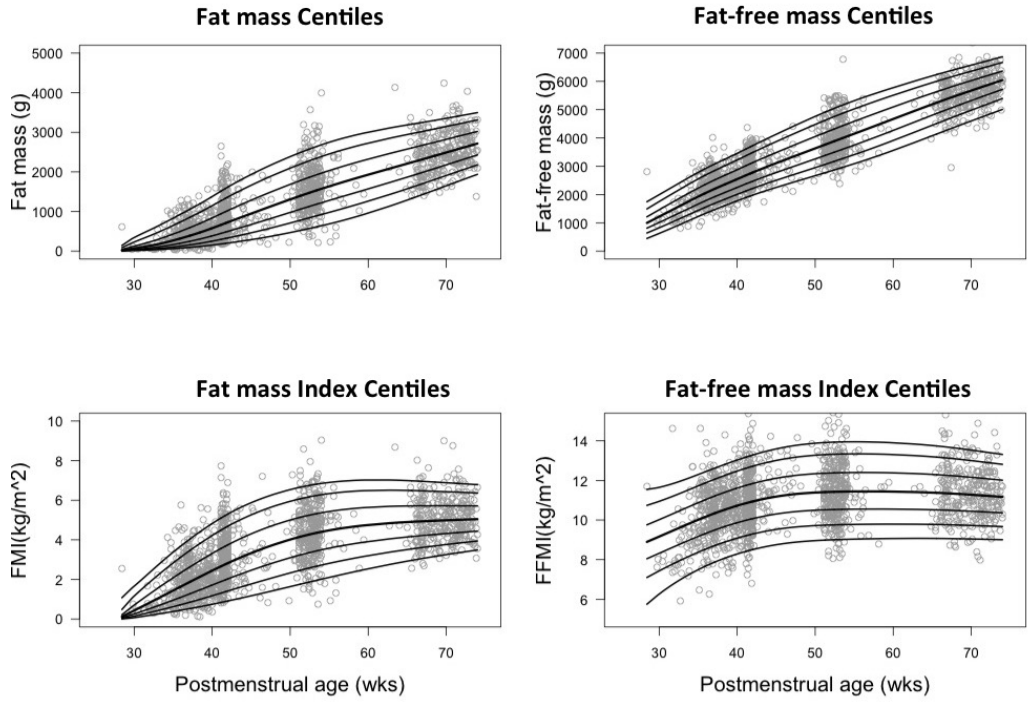
Figure 4. Growth curves showing 3rd, 10th, 25th, 50th, 75th, 90th, and 95th centiles for preterm infants constructed from imputed